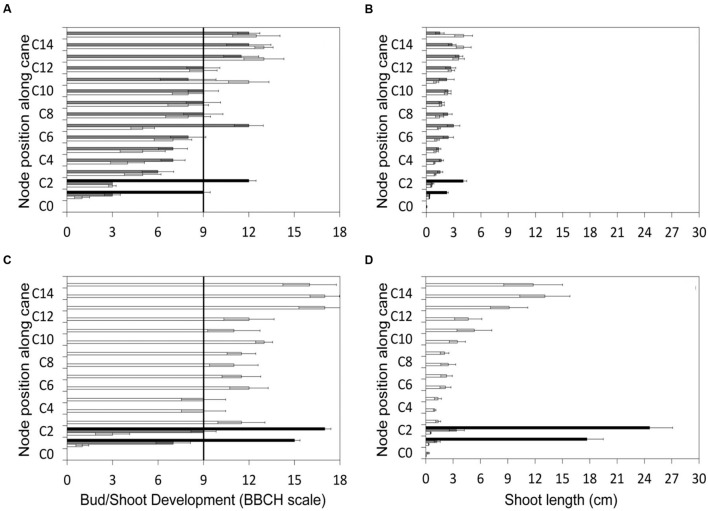
Gradient of canopy growth along the cane recorded for the three pruning treatments before late winter pruning (LWP) (top panels) and very late winter pruning (VLWP) (bottom panels). Growth is given both as BBCH phase (A,C) and shoot length (B,D). Cn represents node position along the cane. Vertical bars on the left side of panels indicate bud-burst according to BBCH scale (Lorentz et al., 1995).